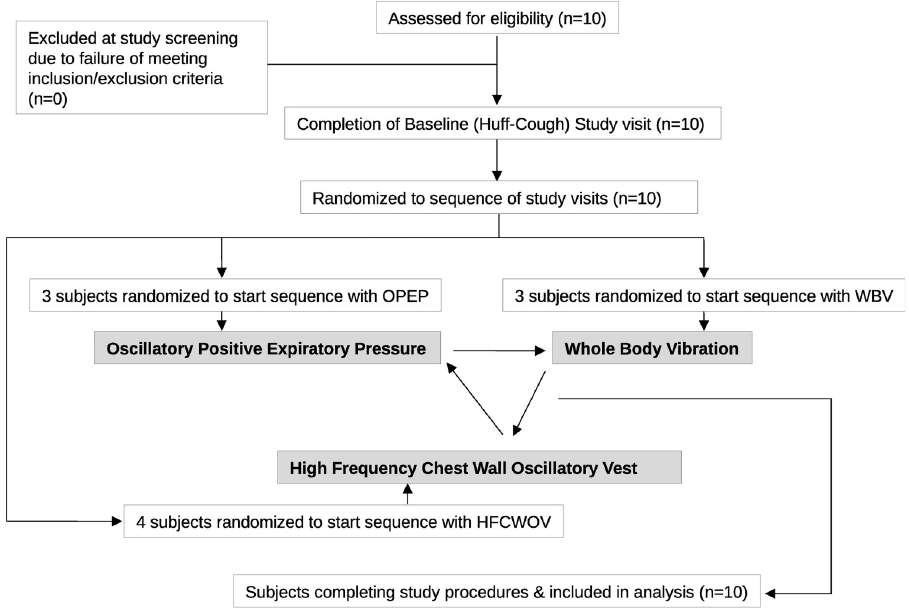
Fig 1. Subject flow diagram. Ten subjects were recruited and completed all study procedures. Following screening, subjects performed baseline/huff-cough measurements before being randomized to a sequence in which to complete the other studied ACT methods. All recruited subjects were included in the